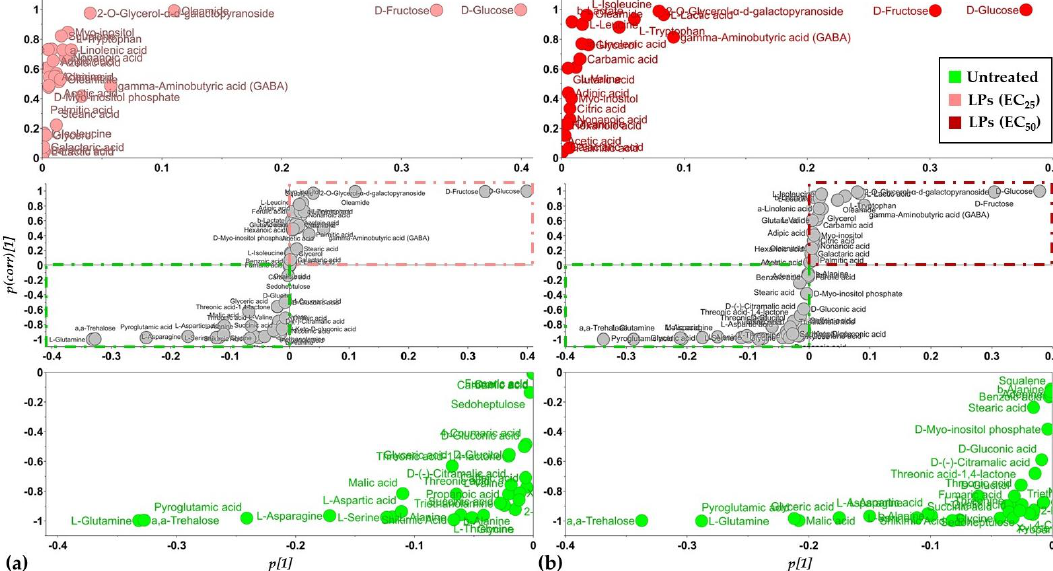
Figure 6. S-plots for the visualization of the OPLS-DA predictive component loadings for the study of the toxicity of the Bacillus sp. PTA13 lipopeptide extract on the metabolism of Lemna minor L. The plants were exposed to concentrations equal to the EC 25 (156 μg ‧ mL − 1 ) ( a ) and EC 50 (419 μg ‧ mL − 1 ) ( b ) of the extract and analyses were performed 72 h following exposure. Metabolites located far out on the wings of the S-plot correspond to biomarkers of lipopeptide toxicity. The S-plots are displayed in the middle panels and magnification of the upper right (upregulated metabolites) and lower left (downregulated metabolites) quadrants are displayed in the upper and lower panels, respectively.